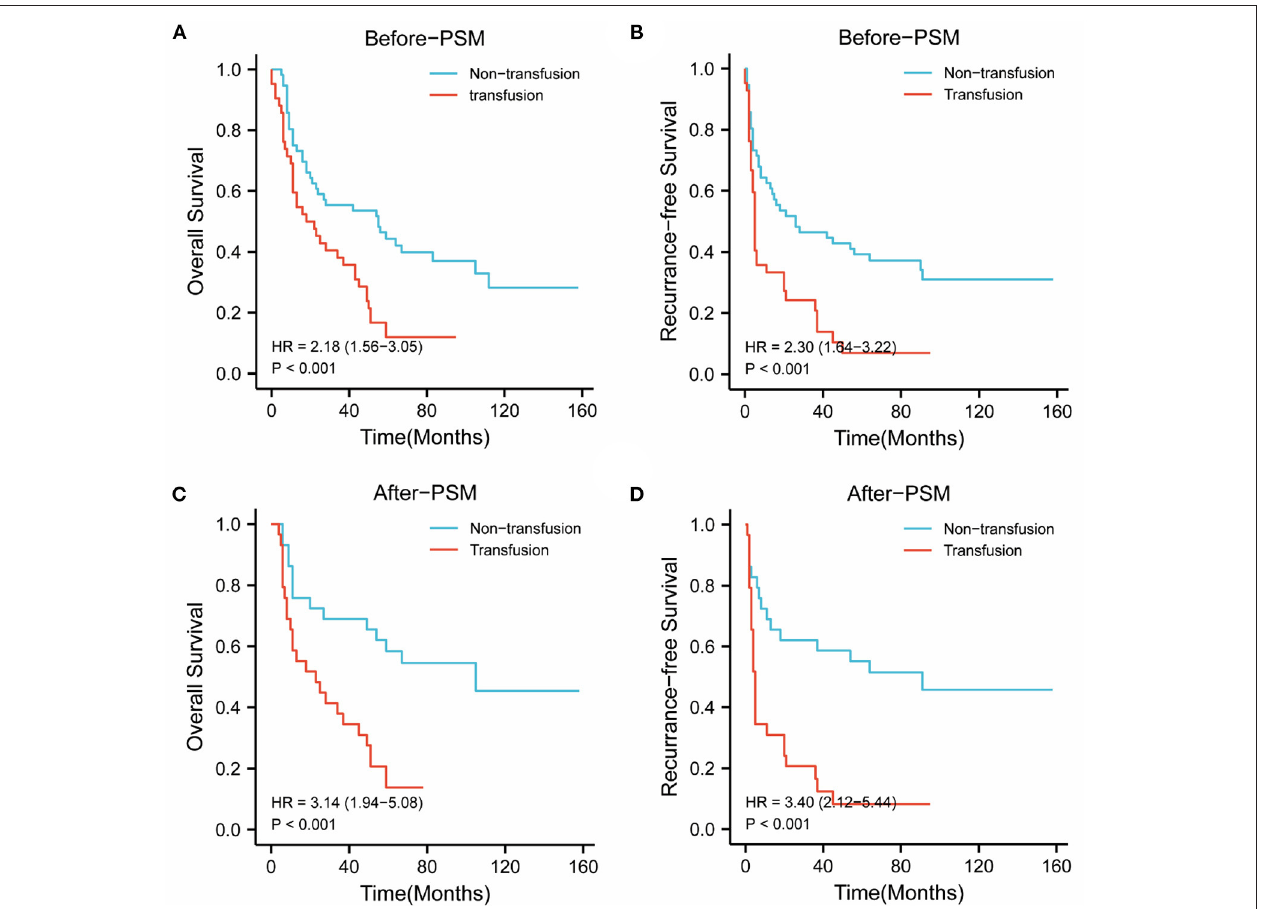
FIGURE 1 | The abscissa time unit is a month. Survival curves of patients with early-stage (BCLC stage A) tumors. (A) overall survival rates of the transfusion and nontransfusion groups before PSM ( p < 0.001). (B) Recurrence-free rates of the transfusion and nontransfusion groups before PSM ( p < 0.001). (C) OS survival rates of the transfusion and nontransfusion groups after PSM ( p < 0.001). (D) RFS rates of the transfusion and nontransfusion groups after PSM ( p <